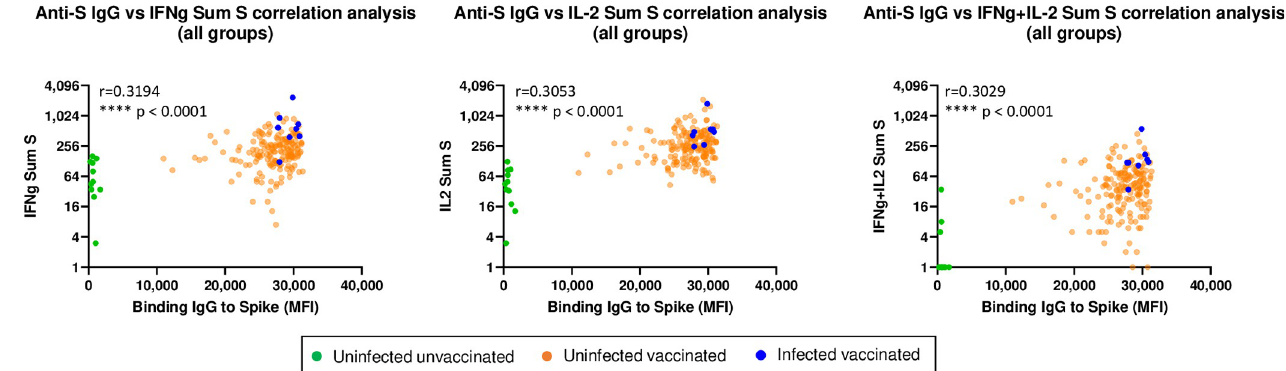
Fig 3. Correlations between summed IFN- γ , IL2, and IFN- γ +IL2 responses to S sub-pools and serum IgG responses to Spike glycoprotein. Summed IFN- γ , IL2, and IFN- γ +IL-2 responses (spot forming cells/million PBMCs, sfc/m) to S glycoprotein correlated with serum IgG responses to Spike glycoprotein. Total n per graph = 198: Uninfected unvaccinated n = 11, Uninfected vaccinated n = 179, Infected vaccinated n = 8. Of note, 8 individuals in the uninfected unvaccinated group and 2 individuals in the uninfected vaccinated group had values of zero for frequencies of cells producing both IFN- γ and IL-2 in response to S peptides. While the zero values were used for statistical analyses, they were plotted as values of 1 to enable visualization on the log axis. Correlations were assessed using the non-parametric Spearman’s correlation analysis.